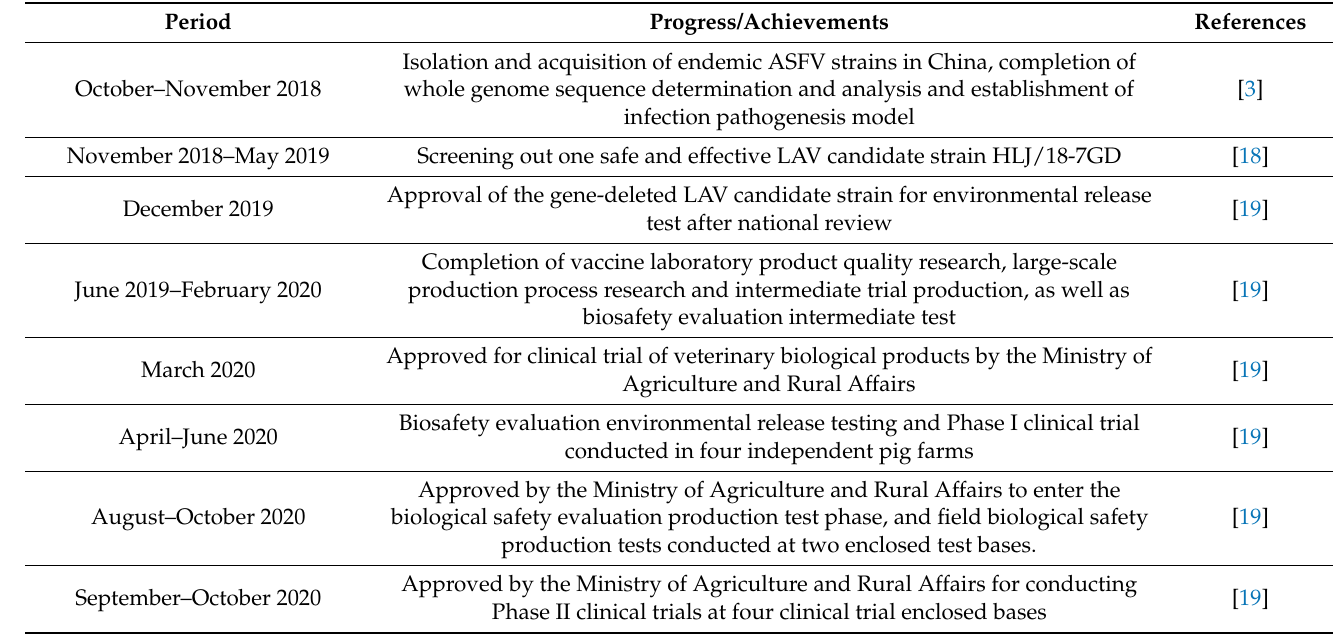
Table 1. Advances in ASFV seven-gene-deleted attenuated vaccine (HLJ/18-7GD strain) development.